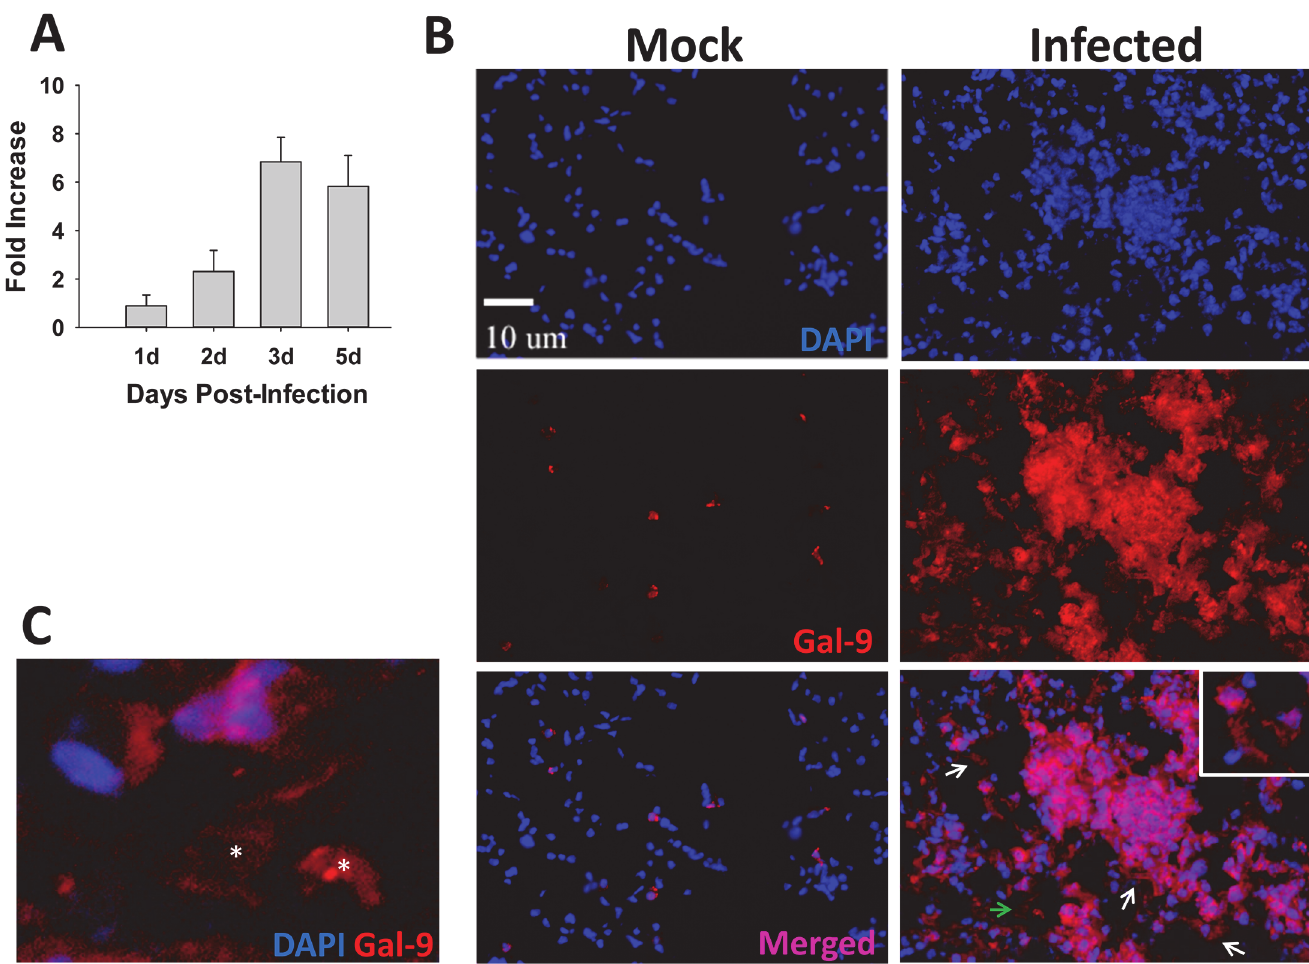
Fig 1. Galectin-9 is upregulated and released in lungs of mice during respiratory F . novicida (F.n.) infection. (A) Total RNA was extracted by Trizol method from lungs harvested at the indicated times after infection with the F.n. strain U112. The mRNA levels of galectin-9 were analyzed by real-time PCR as described in Materials and Methods and are expressed as fold increase over the levels in mock control mice. Data shown are the averages of 3 – 4 mice per group. (B) In-situ IF staining of frozen lung sections from mock control and U112 infected mice harvested at 3 dpi. The sections were stained for galectin- 9 (red) using a purified rat galectin-9 antibody followed by Alexa-546 conjugated chicken anti-rat antibody. Nuclei (blue) were stained with 4 ’ 6 ’ diamidino- 2-phenylindol-dilactate (DAPI). Magnification X 200. Inset depicts possible extracellular galectin-9 in infected mouse lungs. The area indicated by green arrow has been enlarged and shown in (C) . Asterisks depict galectin-9 present in cell-free